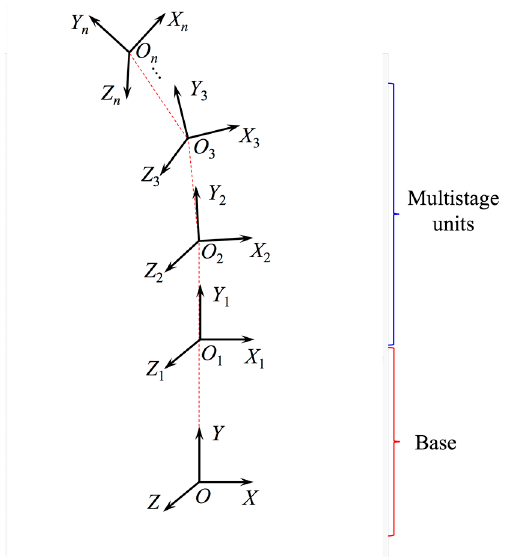
Figure 4. Establishment of the coordinate system of the continuous robot model. Table 1. D-H parameters of space continuous robot.